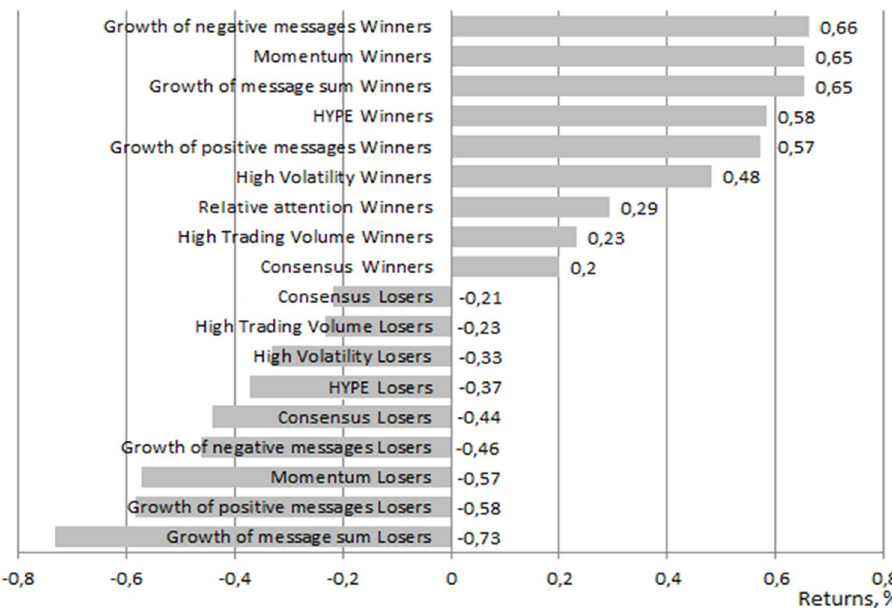
Fig 2. Monthly excess returns on each winner and loser portfolio over a short period. Source: the authors’ calculations. Note: Over a short period, the HYPE winner portfolio generated a monthly excess return of 0.58% to an investor. The winner portfolio composed based on the growth of negative messages generated a monthly excess return of 0.66% to an investor.